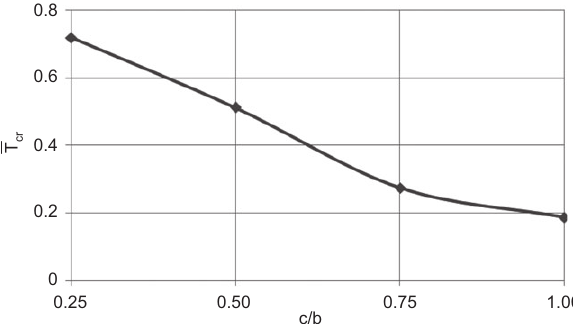
Figure 5 Effect of taper ratio on critical thermal buckling load for trapezoidal plate.